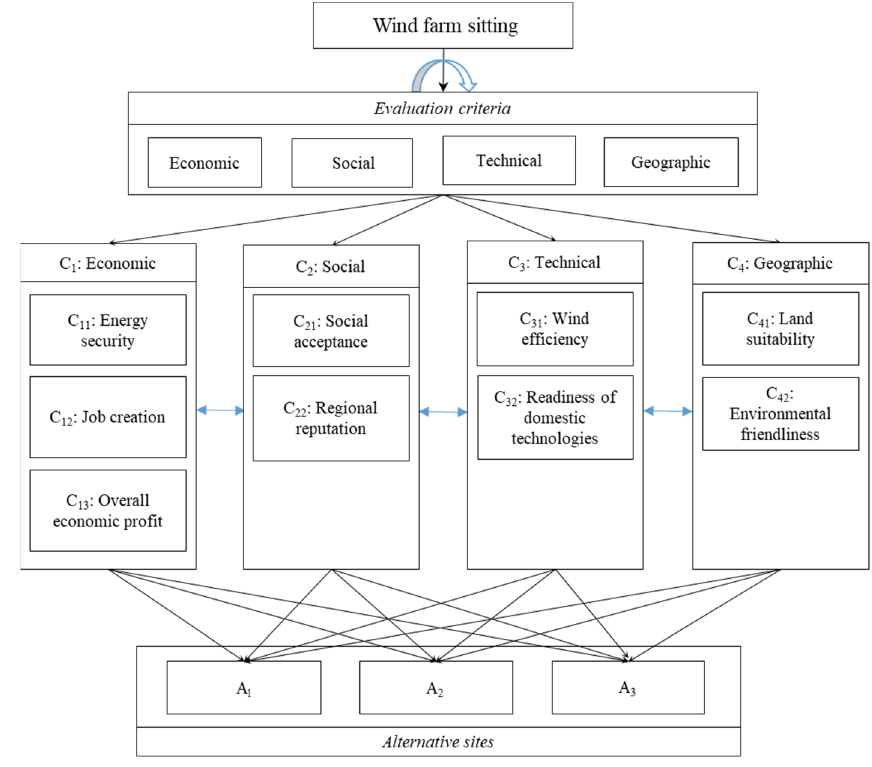
Figure 4. A network model for wind farm site selection .